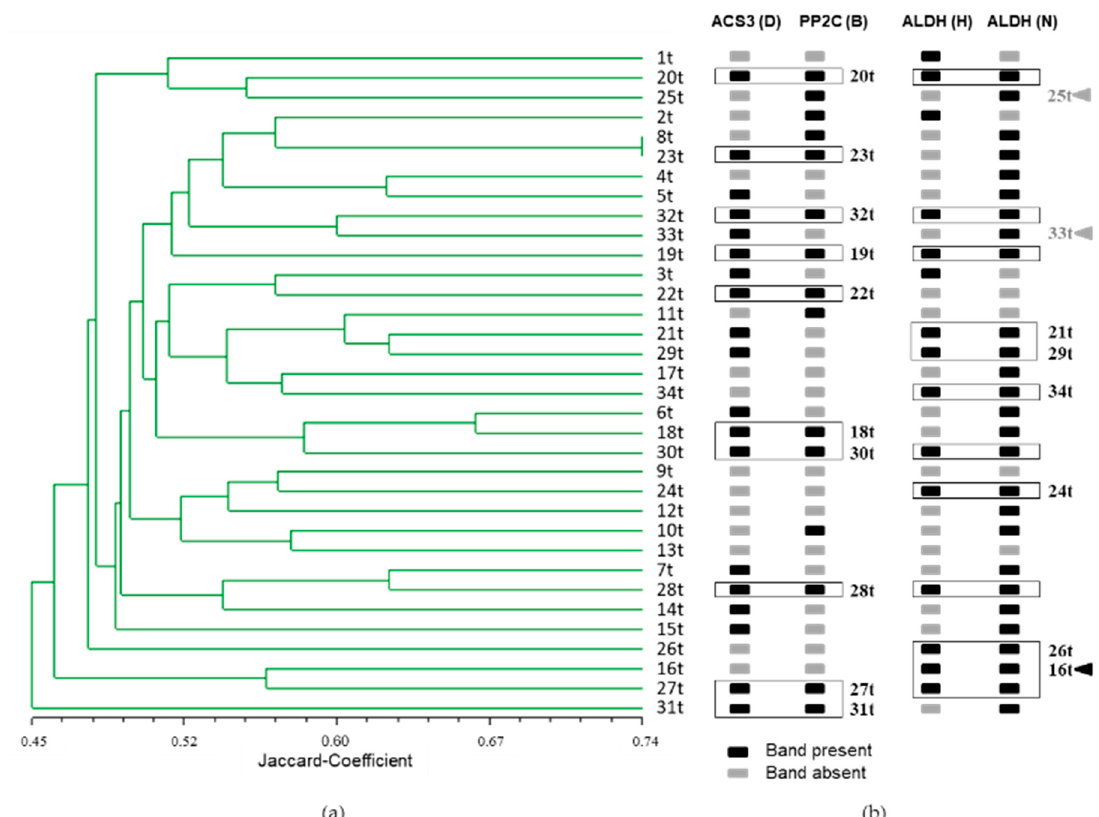
Figure 6. Clustering of the 34 potato varieties based on the genetic similarity obtained by SSR analyses and selection with SSR markers. ( a ) UPGMA dendrogram of the 34 potato varieties (1t = most drought tolerant, 34t = most sensitive) based on all 75 SSR primer combinations derived from candidate genes for drought tolerance, Mantel coefficient r = 0.62; ( b ) Selection by applying four SSR markers associated with drought sensitivity. Black box= band is present, grey box= band is absent. The varieties are ordered according to the UPGMA dendrogram. Boxed varieties are selected by the presence of two marker bands either in the combination HRO_ACS3_D and HRO_PP2C_1_B or the combination HRO_ALDH_H and HRO-ALDH_N. Black Arrow head = falsely negative selected; Grey arrow head = falsely positive selected.